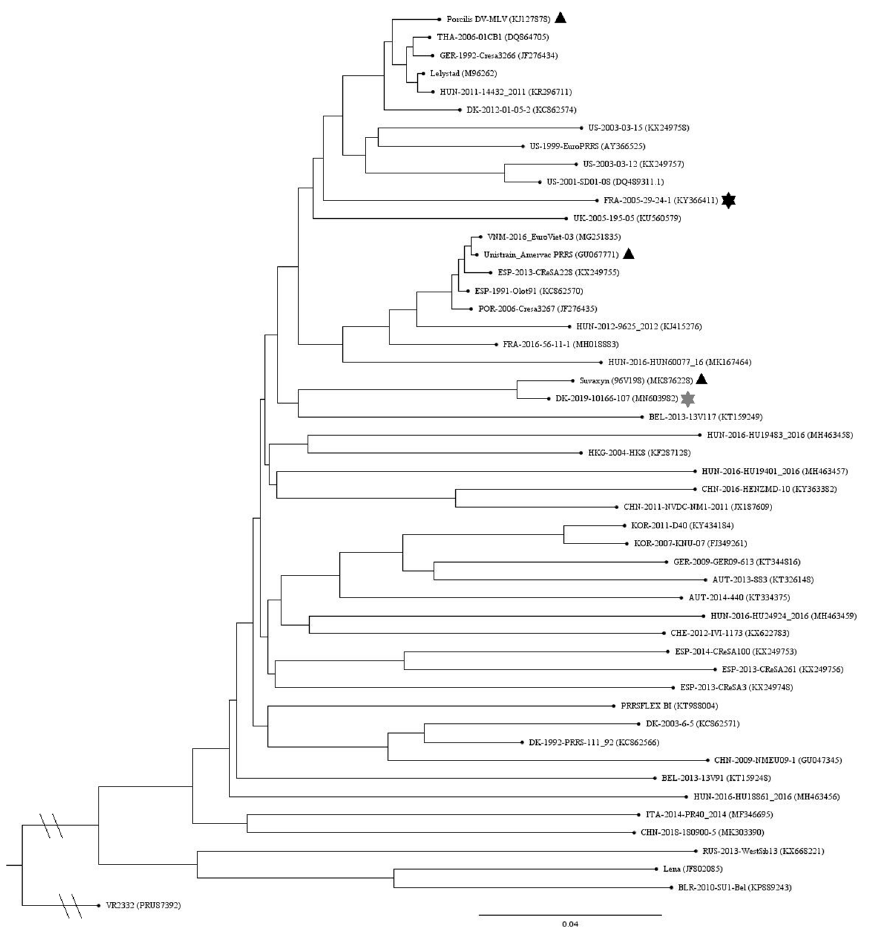
Figure 1. Phylogenetic tree of ORF1–ORF7 global representative PRRSV-1 nucleotide sequences. The three vaccine strains are marked with black triangles and the challenge (REC) and reference (REF) strains are marked with grey and black stars, respectively. The tree was constructed with the Neighbor-Joining algorithm and 1000 bootstrap replicates and visualized in FigTree v.1.4.4.